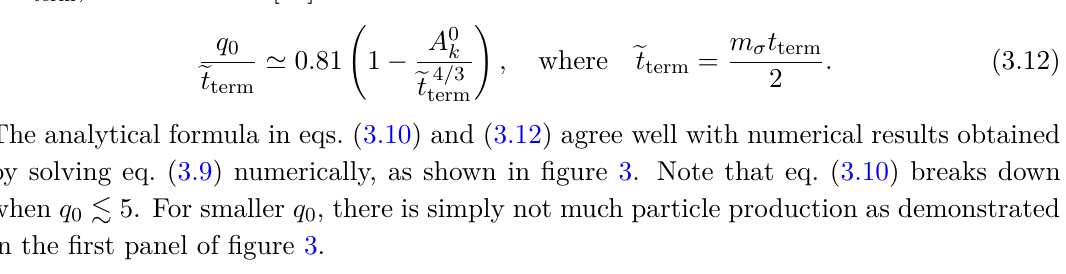
Figure 3 . The logarithm of the comoving occupation number n k as a function of time for k, A 0 and different choices of q 0 . Numerical results are shown by black curves. The red dashed lines show the analytical estimates based on eq. (3.10). The orange dotted lines indicate e t term estimated using eq.